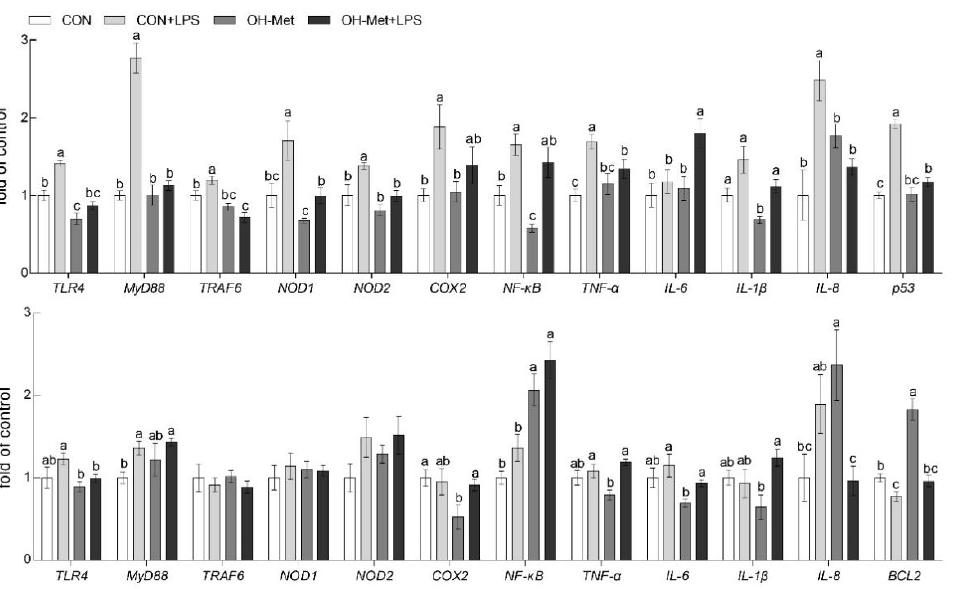
Figure 3. The effects of OH-Met supplementation on TLR4 and NODs signal-related genes of the ( A ) liver and ( B ) spleen after 24 h LPS challenge in weaned piglets. The values are the means ± SEs, n = 5. The labeled means without a common letter differ, p < 0.05. CON, piglets receiving a control diet and injected with saline; CON+LPS, piglets receiving the control diet and challenged with LPS; OH-Met, piglets receiving a diet that was supplemented OH-Met at 25% above the total SAA present in the CON diet and injected with saline; OH-Met+LPS, piglets receiving a diet that was supplemented OH-Met at 25% above the total SAA present in the CON diet and challenged with LPS.